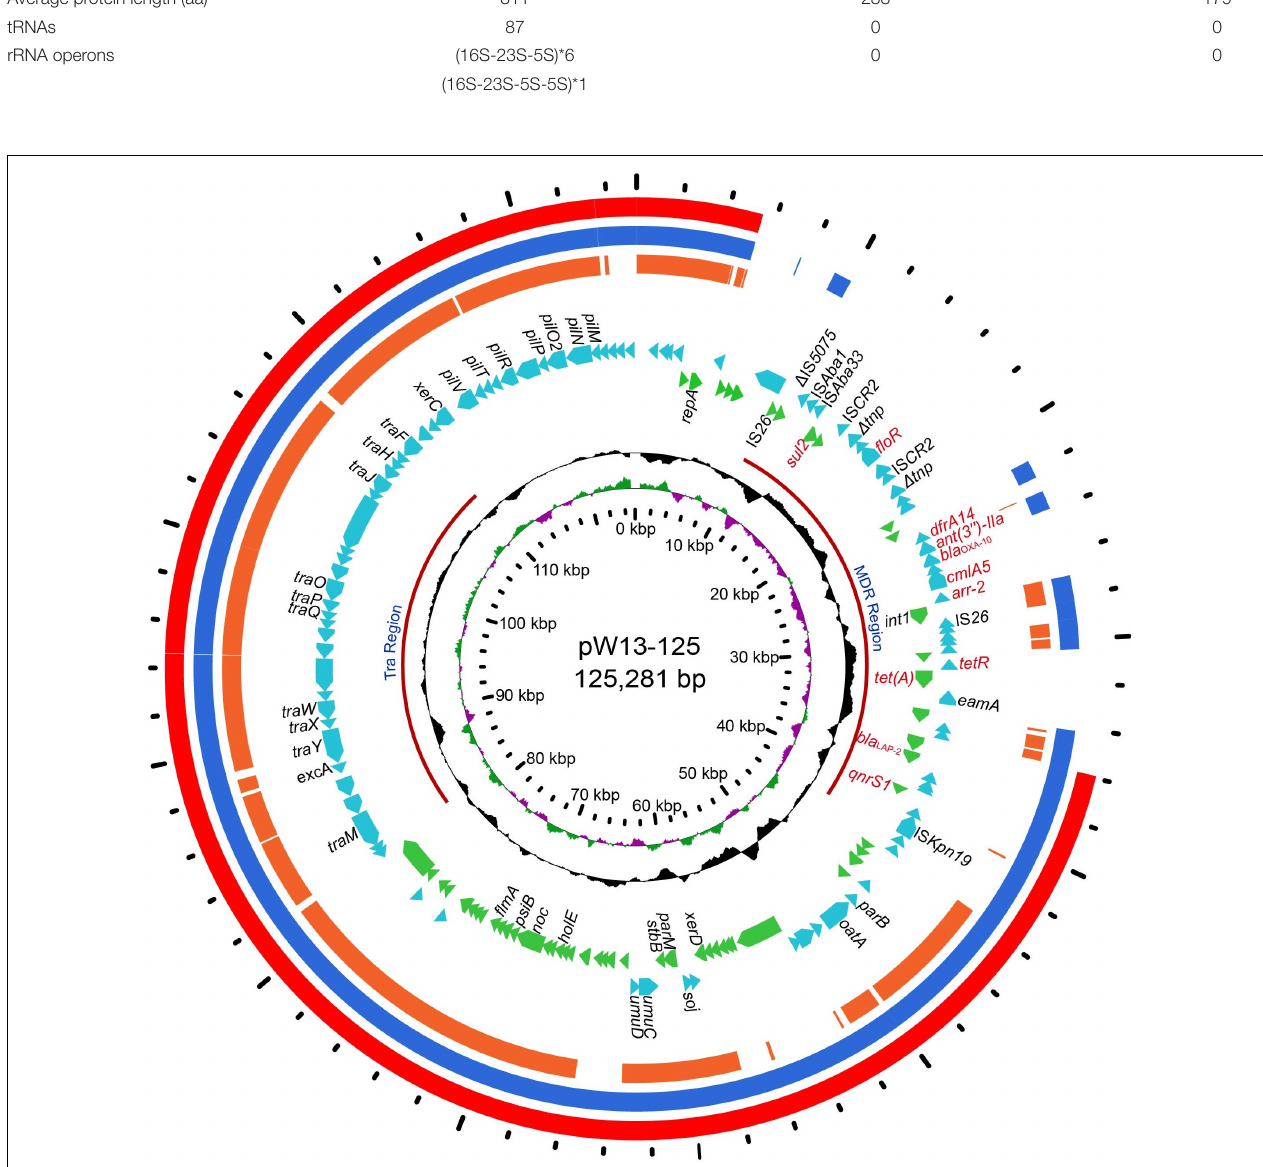
FIGURE 1 | The circular map of pW13-125 and comparative genomics analysis with other closely related plasmids. Circle 1 (from inside to outside) shows the scale in kb. Circles 2 and 3 show the GC skew and GC content, respectively. Circle 4 shows the two different functional regions. Circles 5 and 6 present genes encoded in the forward strand and reverse strand, respectively. Circles 7–9 show the homologous regions of pOP-I (KY126370), an unnamed plasmid (CP027111) and p34399 (CP010385), respectively, and the regions without similar hits were left blank.